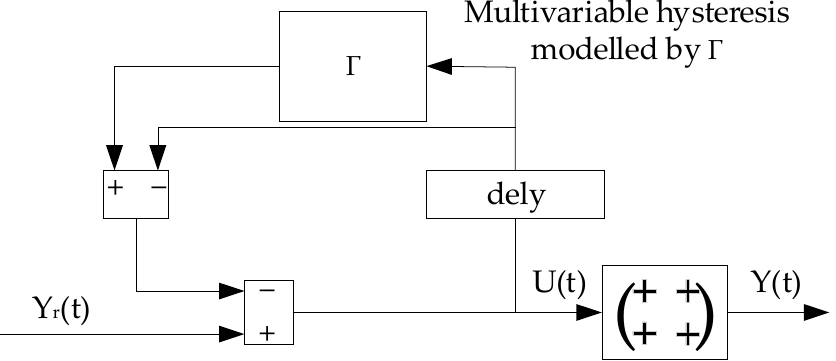
Figure 6. Diagram showing the implementation of the multivariable compensator. Chen et al. [42] designed an insulated gate bipolar transistor (IGBT) parameter